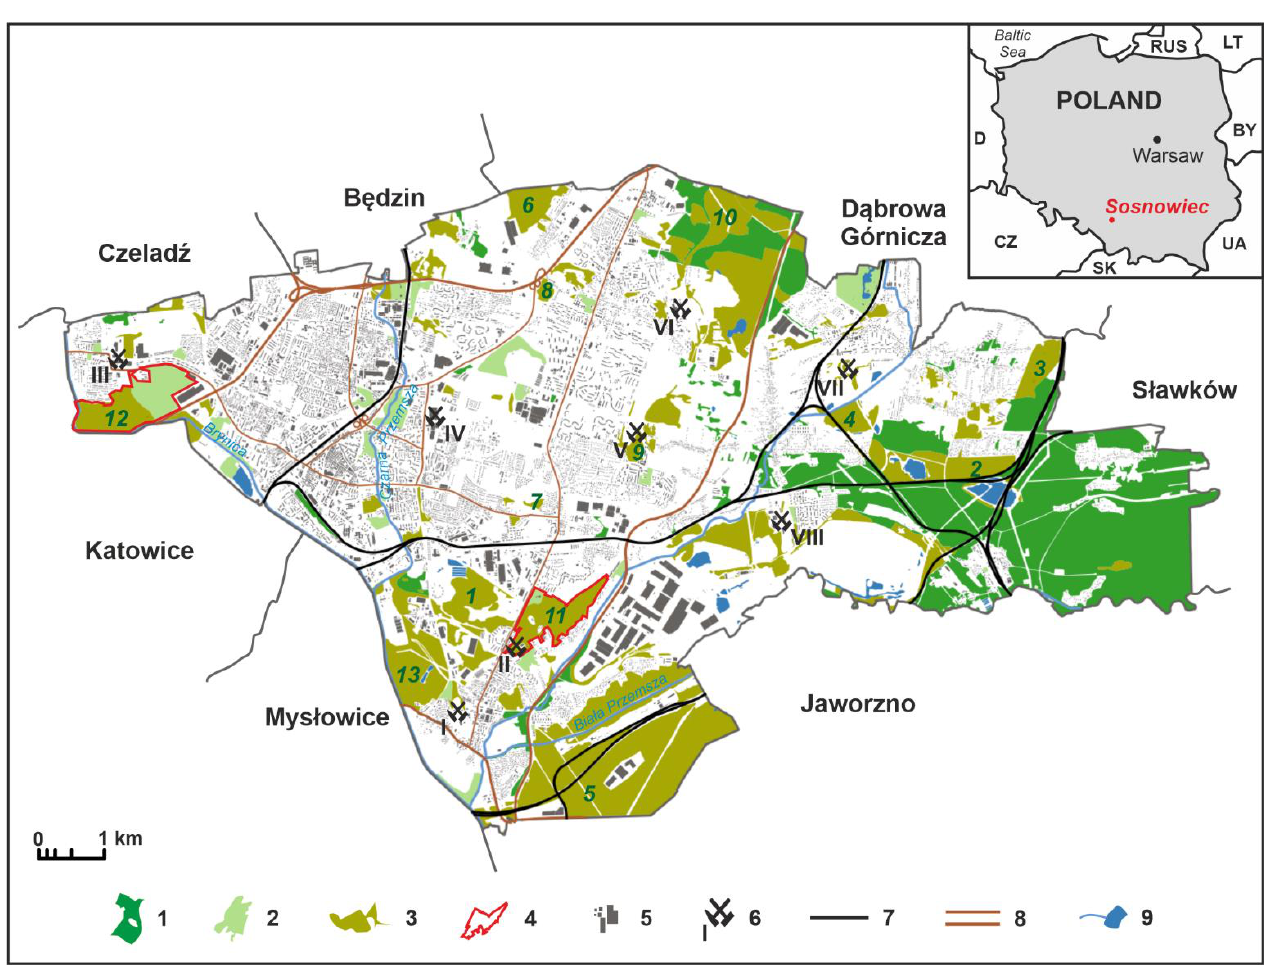
Figure 1. Forested areas in city of Sosnowiec, 2021. Explanations: 1 — forests, 2 — parks, 3 — forests on the brownfield sites, 4 — forest described in the article, 5 — built-up areas, 6 — closed coal mines, 7 — main railways, 8 — expressways, 9 — rivers, and reservoirs. Names of highlighted postmining forests: